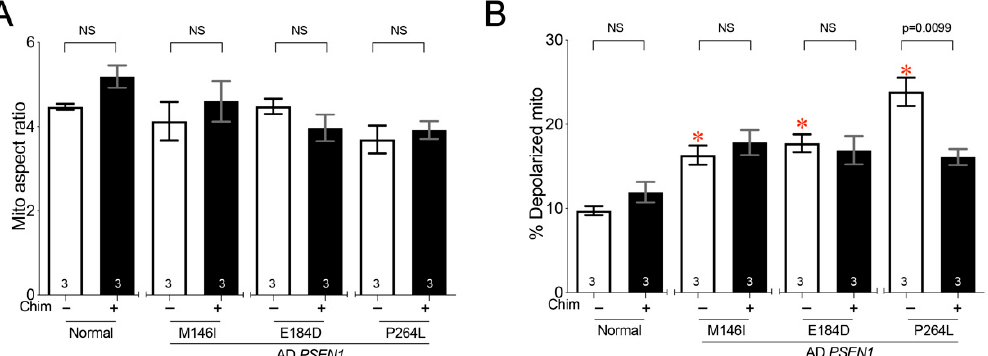
Figure 5. PSEN1 mutant Alzheimer’s disease fibroblasts exhibit mitochondrial depolarization that is improved by mitofusin activation. ( A ) Quantitative results for mitochondrial aspect ratio. ( B ) Depolarization of galactose-cultured normal and AD patients’ fibroblasts treated with 100 nM Chimera or DMSO vehicle. Data are means ± SEM; p values by two-way ANOVA; * = p < 0.05 vs. vehicle-treated normal fibroblasts; individual p values are given for Chimera vs. vehicle within each genotype. NS = Nonsignificant. The number of independent experiments is shown on the bottom of each bar.